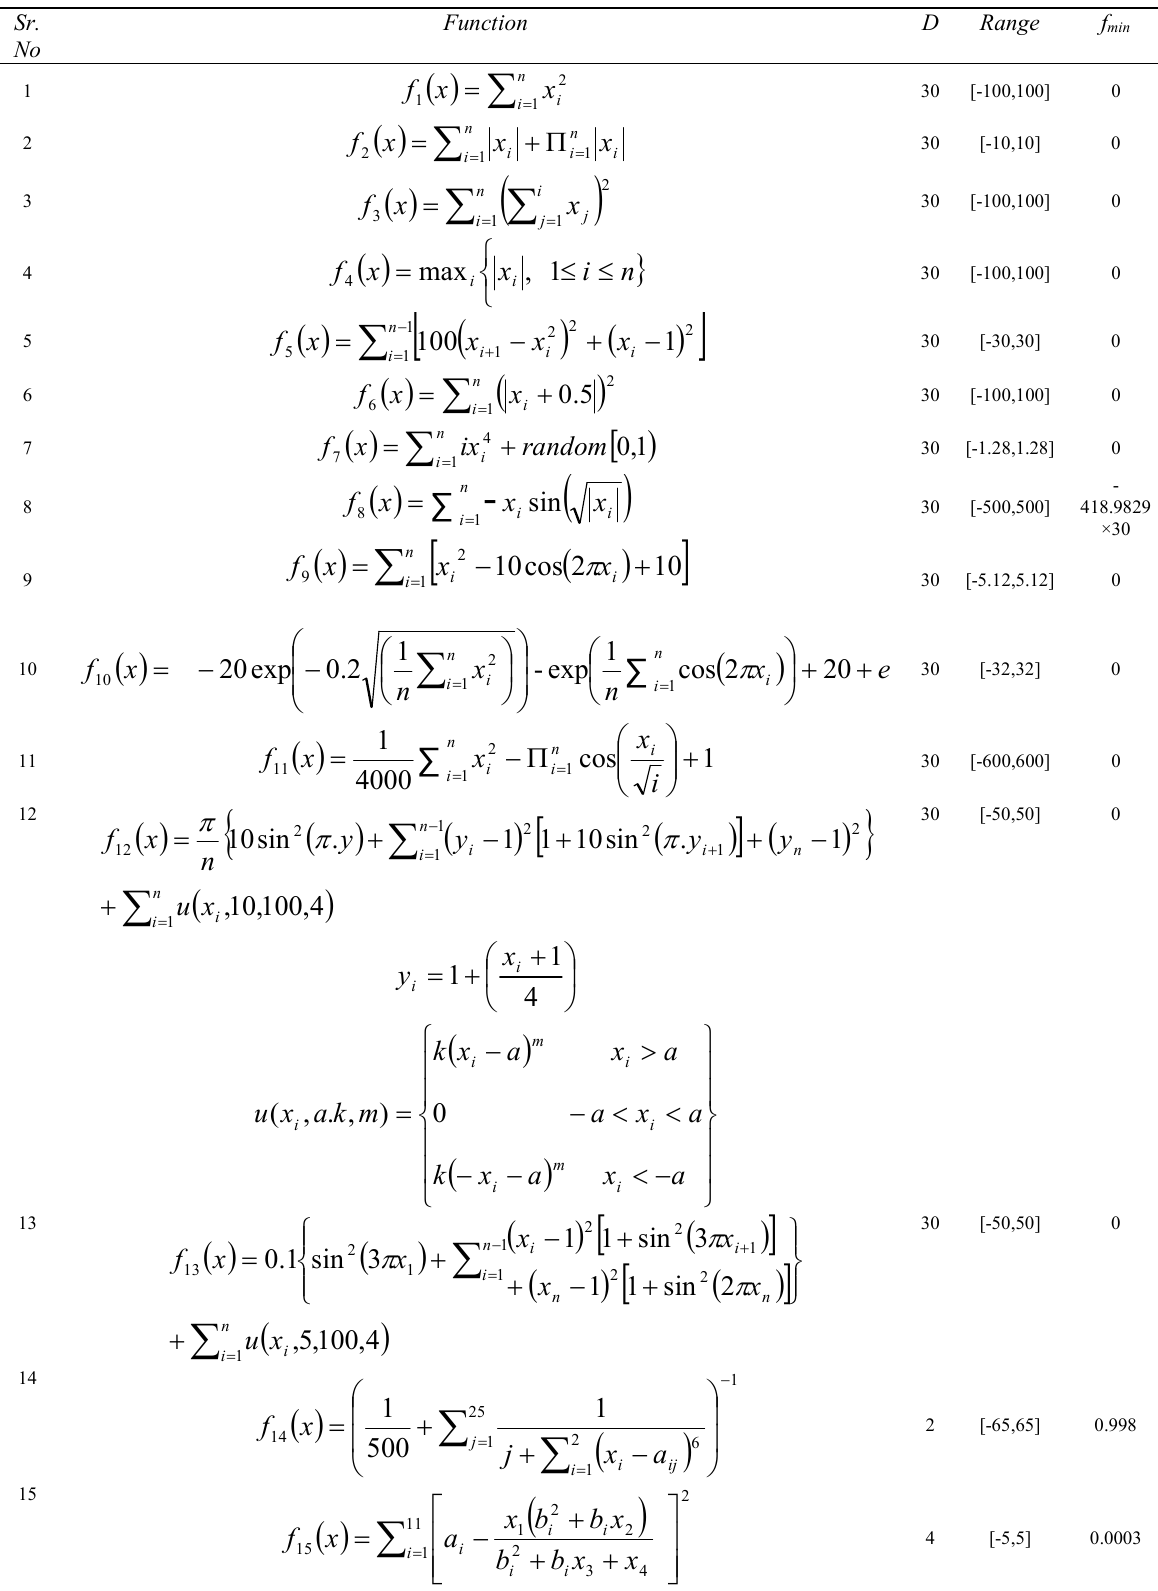
Unimodal, multimodal and fixed-dimension multimodal functions (Mirjalili, 2014)